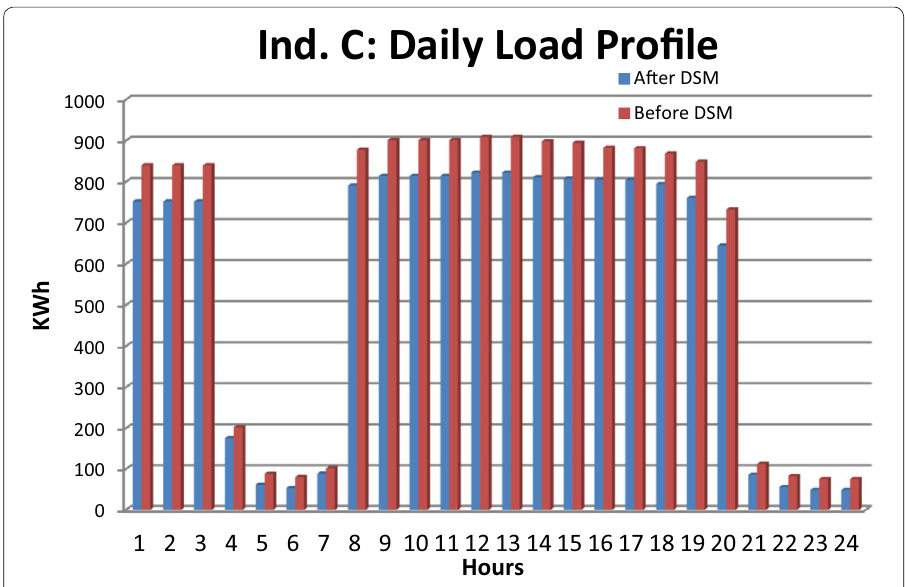
Fig. 7 Load profile for industry C before and after the DSM solution